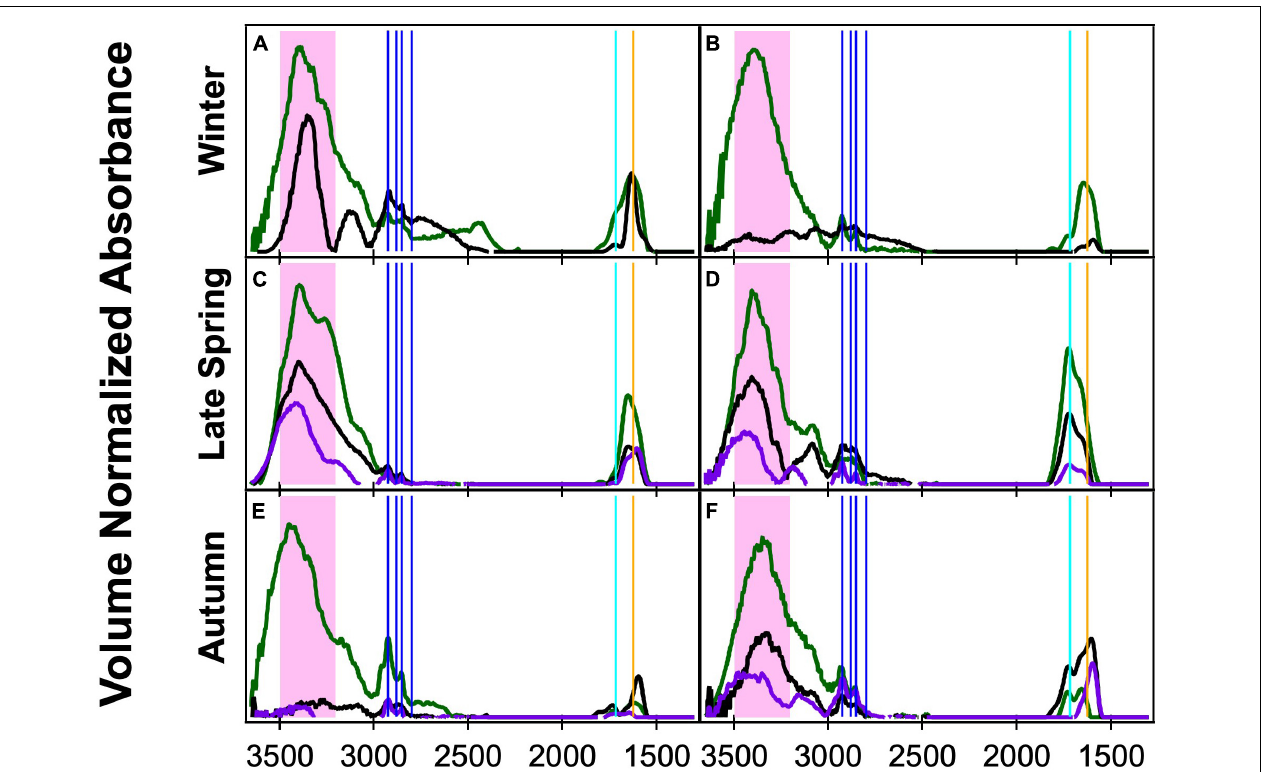
FIGURE 3 | Fourier transform infrared spectroscopy (FTIR) spectra normalized by volume of concurrently sampled filters in three size ranges: < 1 µ m (green), < 0.5 µ m (black), and < 0.18 µ m (purple) during clean marine periods. The spectral peak locations for the OFG are indicated with the hydroxyl region in the shaded pink area, four alkane peaks (vertical blue lines), carbonyl (both acidic and non-acidic, vertical teal line), and amine (vertical orange line). The times of sampling are as follows: (A) 11/12/15 10:00–11/13/15 8:00, (B) 11/24/15 22:00–11/25/15 8:00, (C) 5/15/16 10:00–5/17/16 8:00, (D) 6/1/16 10:50–6/2/16 9:00, (E) 9/9/17 8:00–9/10/17 7:00, and (F) 9/17/17 8:00–9/18/17